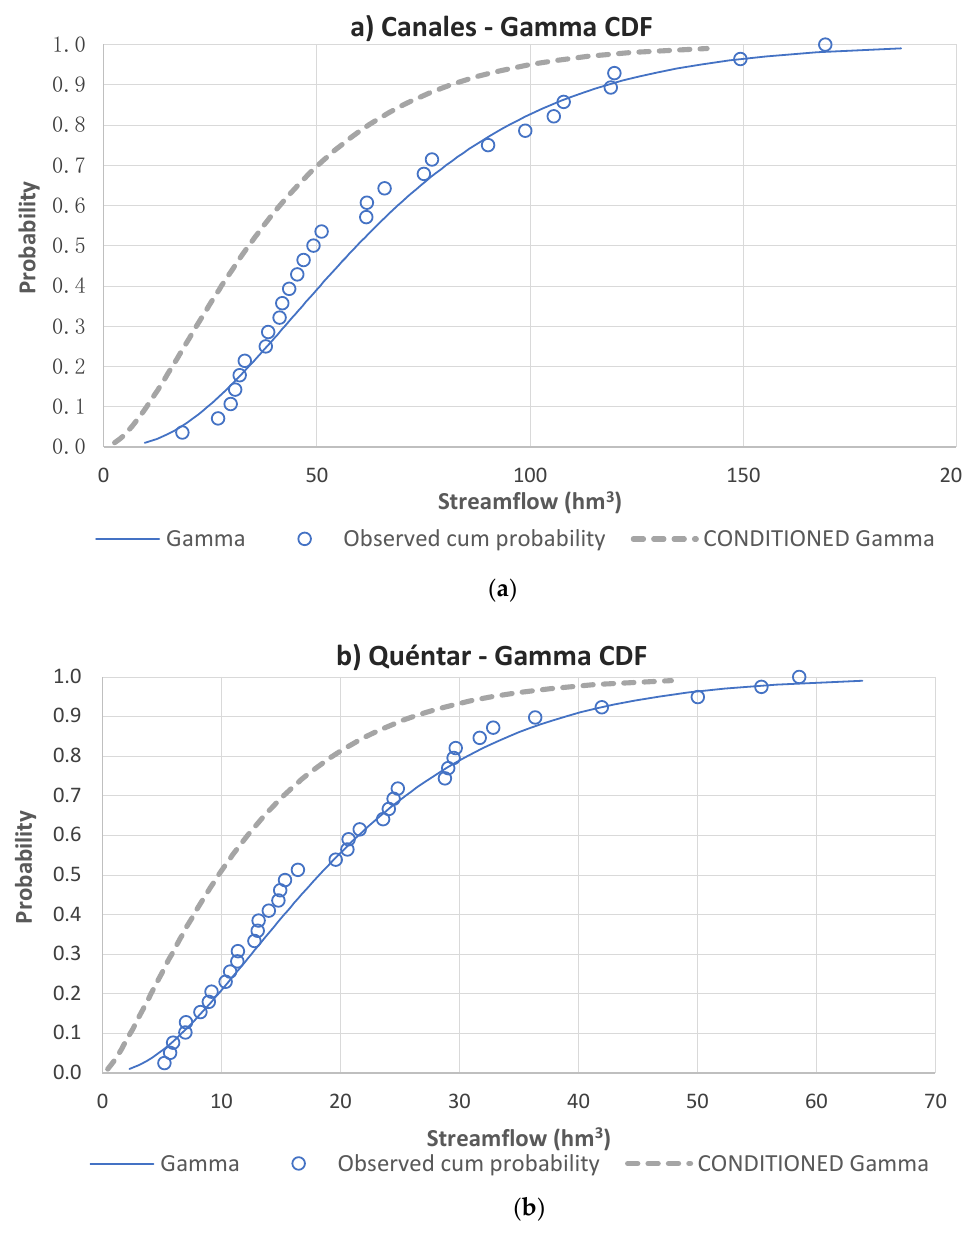
Figure 7 . Two-parameter gamma CDF and conditioned gamma distribution—1st April 2017: ( a ) Canales reservoir (observed data October 1988–September 2016); and ( b ) Quéntar reservoir: (observed data October 1977–September 2016).